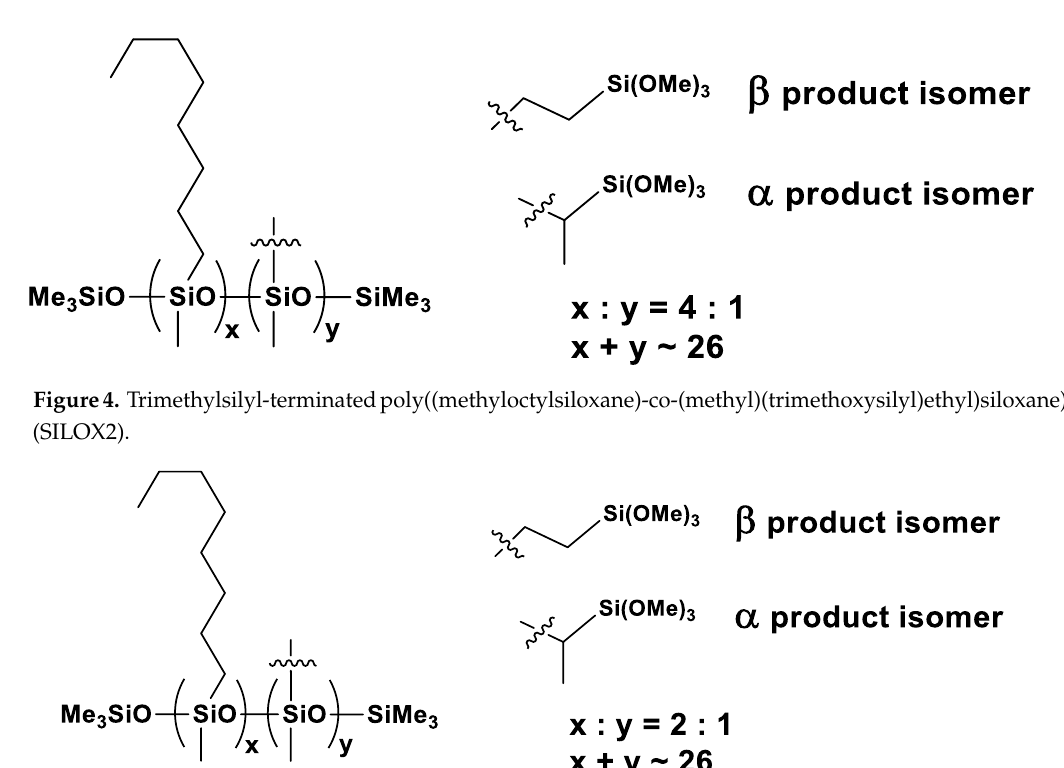
Figure5. Trimethylsilyl-terminatedpoly((methyloctylsiloxane)-co-(methyl)((trimethoxysilyl)ethyl)siloxane)) Figure 5. Trimethylsilyl-terminated poly((methyloctylsiloxane)-co-(methyl)((trimethoxysilyl)ethyl)siloxane)) (SILOX3).